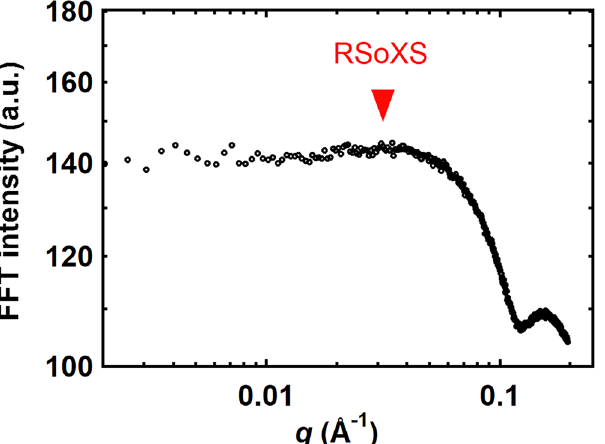
Figure 2. Fast Fourier transform (FFT) intensity as a function of q calculated from the AFM image shown in Fig. 1 of unextracted 11 th scale onion epidermal peel. The arrow denotes the average interfibril spacing determined from